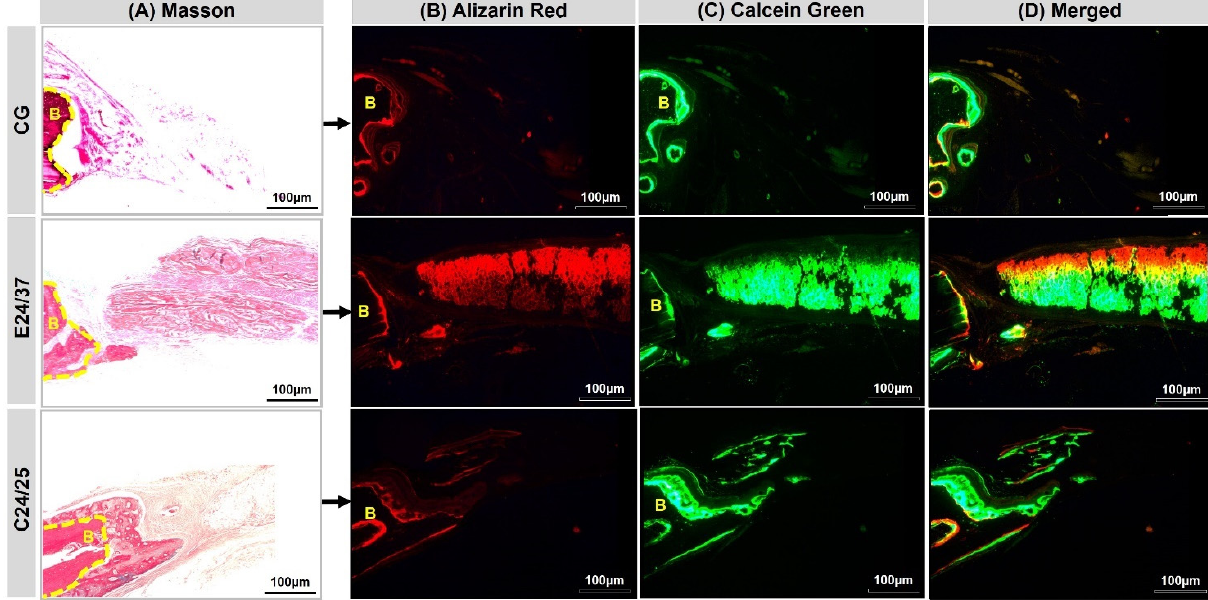
Figure 3. ( A ) Stained sections by Masson’s trichrome corresponding to the images observed in Confocal Laser Scanning Microscopy (CG, E24/37 and C24/25 groups). The different colors show the bone formation at different time periods. ( B ) Alizarin red applied in the immediate postoperative period and seven days after the surgical procedure. ( C ) Calcein green applied at 14 and 21 days after surgical procedure. ( D ) Overlapping images of the two fluorochromes. Remaining bone (B). Objetive ×20, Bar: 100 µm.